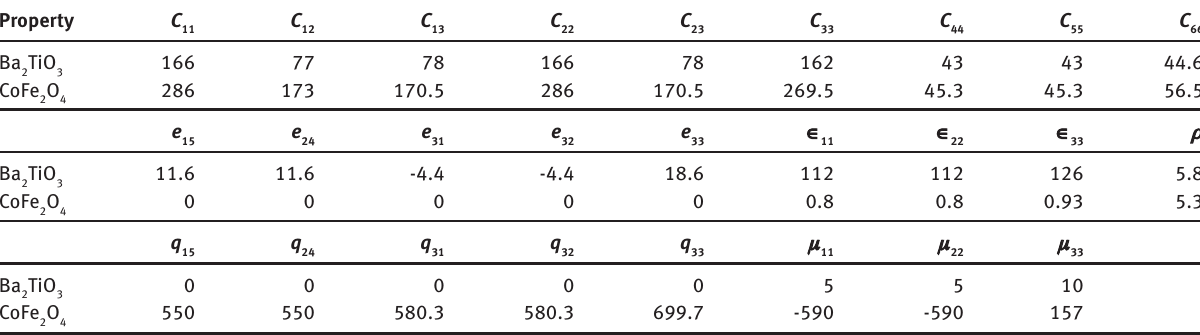
Table 1: Physical parameters of the two materials with polarization in the thickness direction.